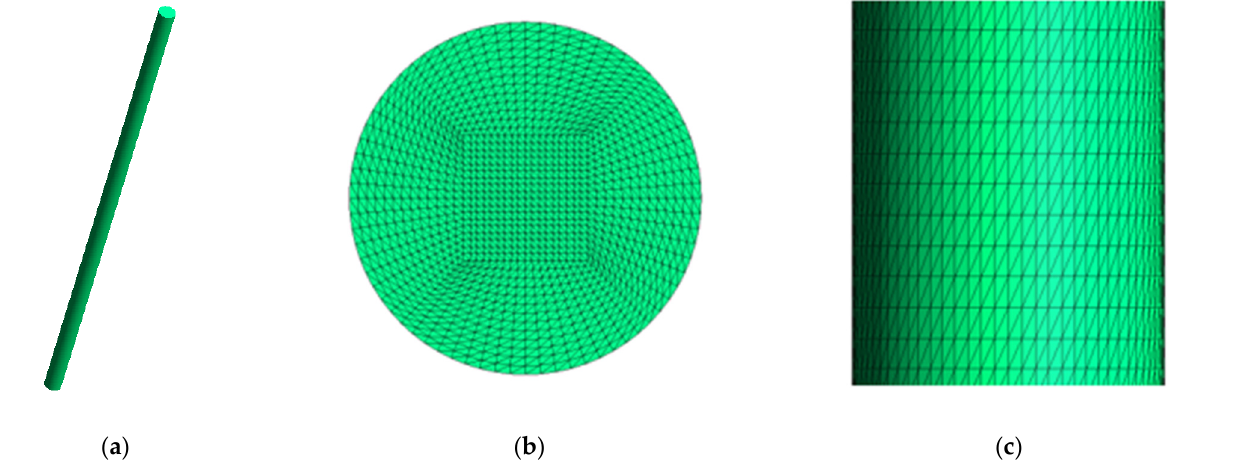
Figure 2. Design of the filament (1.9 mm diameter and 50.3 mm length) and partial views of the meshed geometry (with 4,258,800 elements and 730,431 nodes): ( a ) Initial geometry of the filament; ( b ) Cross section of the discretized geometry; ( c ) Longitudinal cut of the discretized geometry.